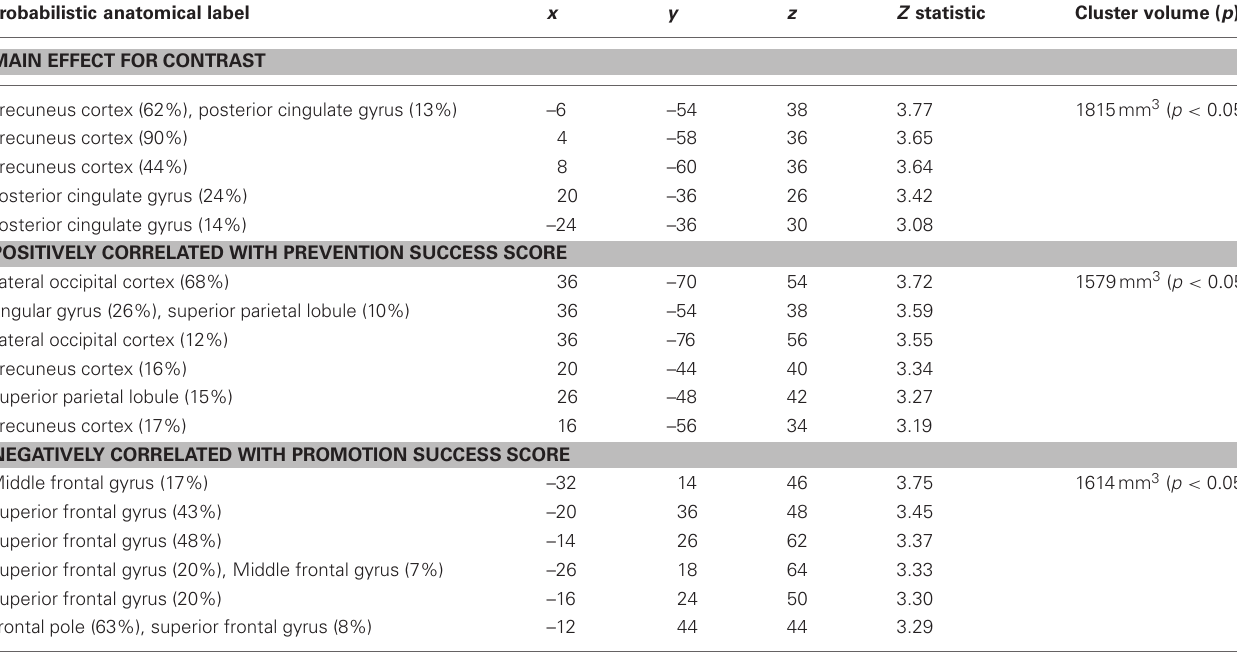
Table 2 | Regions showing significantly greater activation following prevention (ought) priming trials compared to control priming trials. Probabilistic anatomical